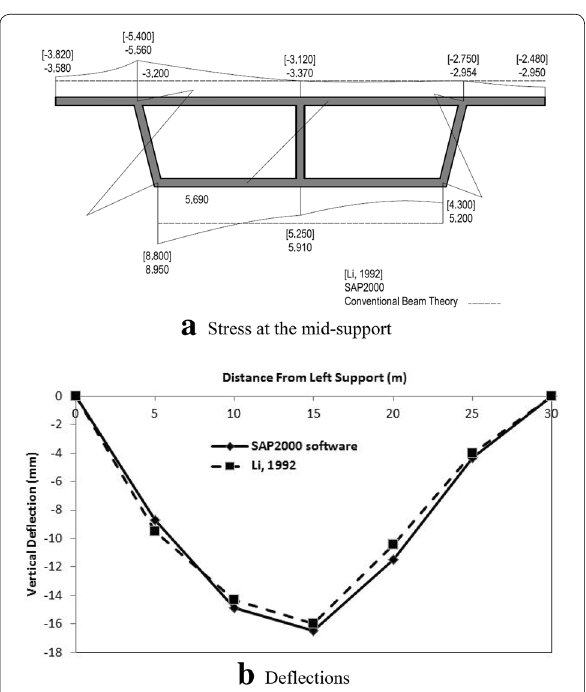
Fig. 6 Distribution of stress and deflection from various